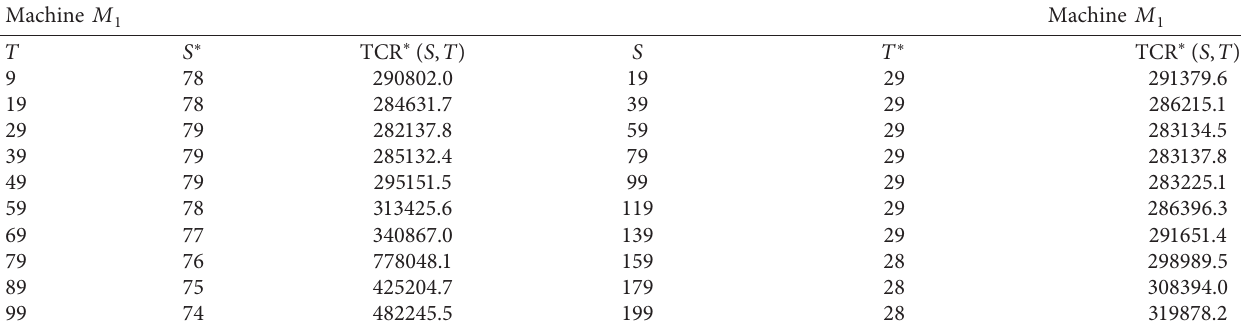
Table 9: The optimal inventory S and the minimum cost ratio under different T and the optimal monitoring time T and the minimum cost rate under different S